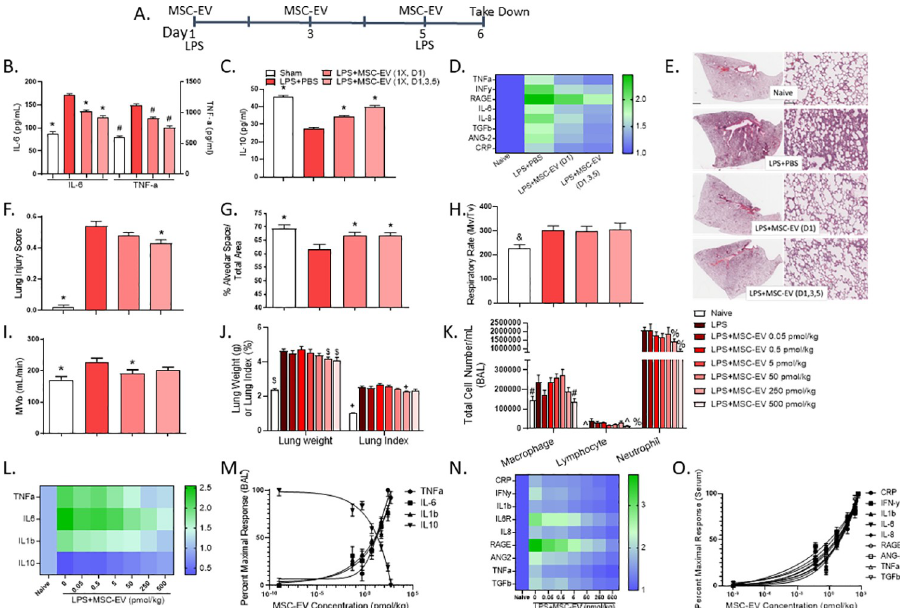
Fig 4. MSC-EV therapy improves ALI in a rat model of the disease. (A) Schematic of the LPS-induced rat model of ALI depicting LPS intratracheal installation and MSC-EV intravascular administration. (B) IL-6, TNF α and (C) IL-10 were measured in bronchoalveolar lavage fluid (BAL). (D) Serum cytokine levels normalized to na ï ve control. (E) histology lung scans (left panel) with representative magnification (right panel). Histology scans were used to calculate (F) Lung injury score and (G) percent alveolar space. Scale bar denotes 2 mm (left panel) and 100 μ m (right panel). Plethysmography (H) respiratory rate and (I) minute volume. (J) lung weight and lung index. (K) infiltrating cells from the BAL. (L) BAL cytokines normalized to na ï ve control. (M) MSC-EV percent maximal response in the BAL. (N) serum cytokines normalized to na ï ve control. (O) MSC-EV percent maximal response in serum. Error bars are SEM of the mean. � p < 0.05 vs LPS (cytokine, lung function); & p < 0.1 vs LPS (lung function) $ p < 0.05 vs LPS (lung weight); + vs LPS (lung index) # P < 0.05 vs LPS (Macrophage); ^ P < 0.05 vs LPS (Lymphocyte); % P < 0.05 vs LPS (Neutrophil).